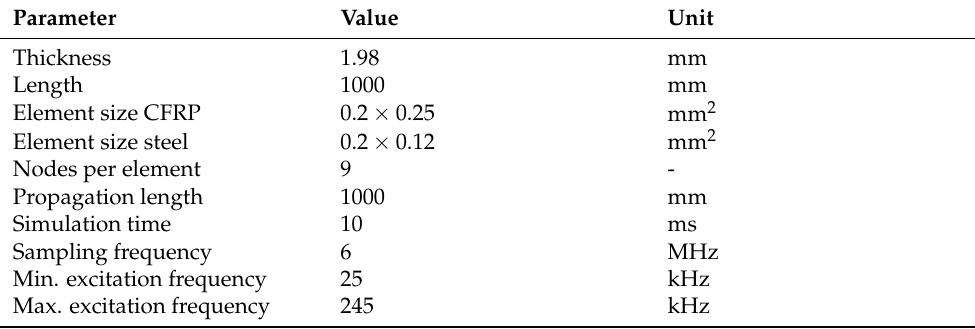
Table 2. Parameters of the numerical 2D model for the computation of dispersion